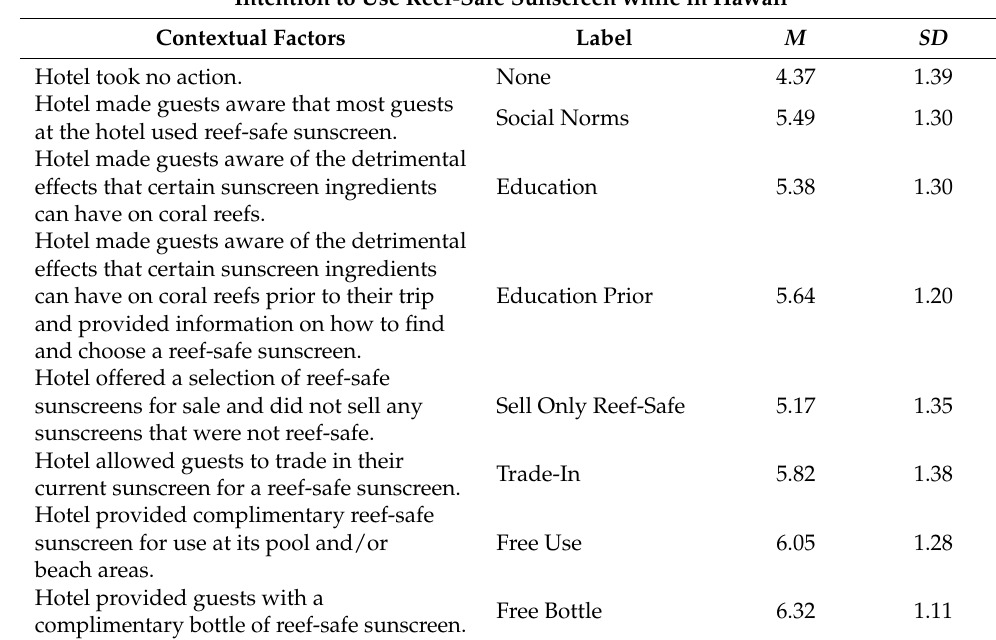
Table 6. Description of Contextual Factors and